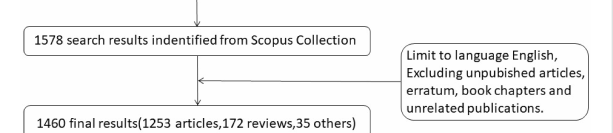
FIGURE 1 Data fi ltration processing and results. A total of 1578 results were found on Scopus using this search strategy. Non-English language articles, unpublished articles, errata, book chapters, and irrelevant literature were excluded. A total of 1460 articles were screened for analysis (including 1253 articles, 172 reviews, and 35 other types of articles).